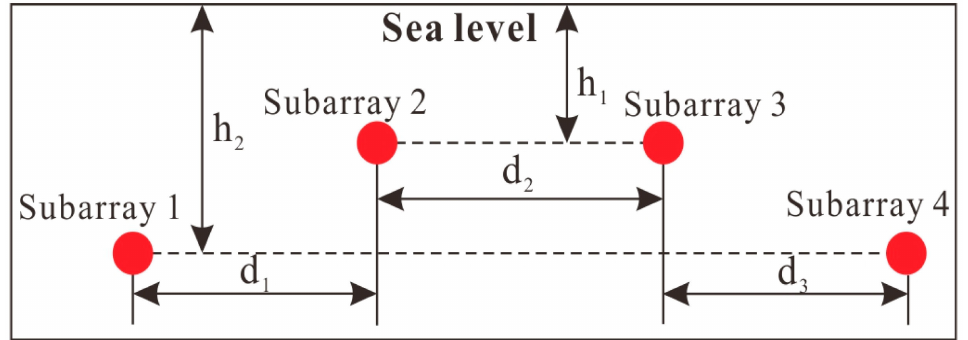
Figure 4. Schematic diagram of the stereoscopic source arrangement, in which h 1 = 5 m; h 2 = 8 m; d 1 = d 2 = d 3